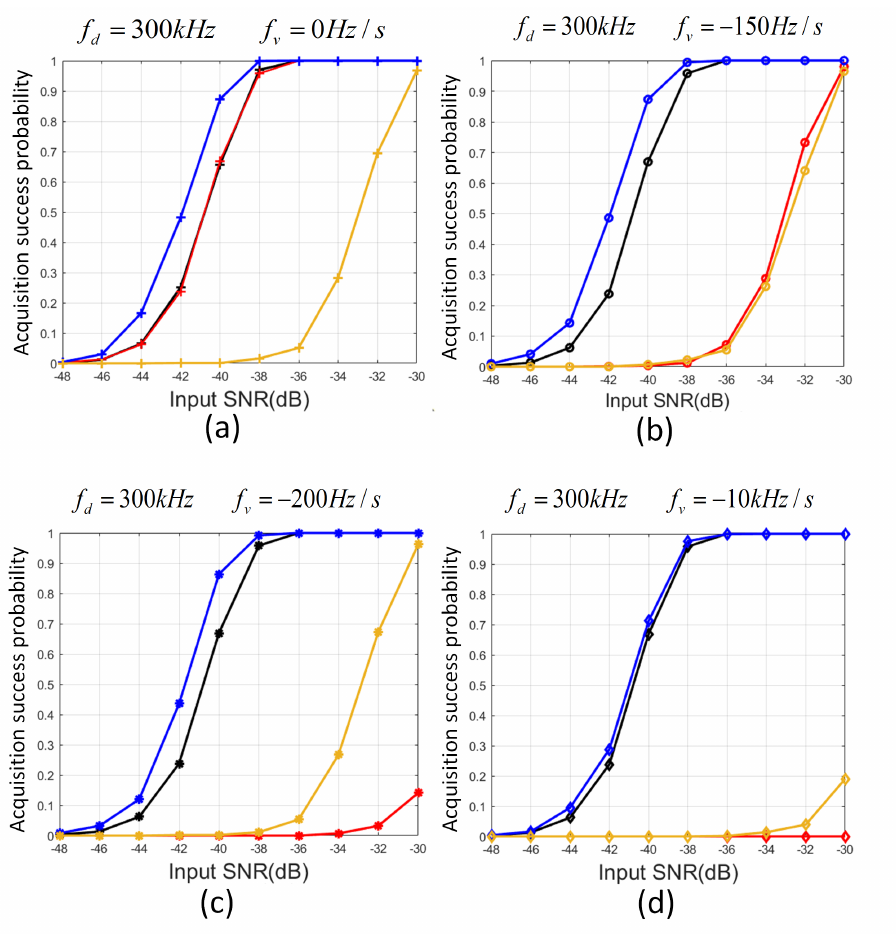
Figure 12. Acquisition success probability under different dynamic conditions (red represents the traditional parallel code phase acquisition algorithm; black represents the ILS improved parallel code phase acquisition algorithm; blue represents the parallel code phase search based on the prior information assistance strategy when the Doppler information deviation is 50 Hz; yellow represents the parallel code phase search based on the prior information assistance strategy when the Doppler information deviation is 150 Hz; the subfigure ( a – d ) represents the performance of the algorithm in different dynamic